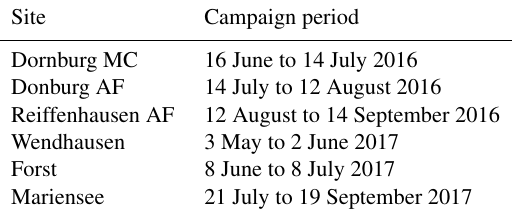
Table B1. Temporal extent of the EC measurement campaigns.